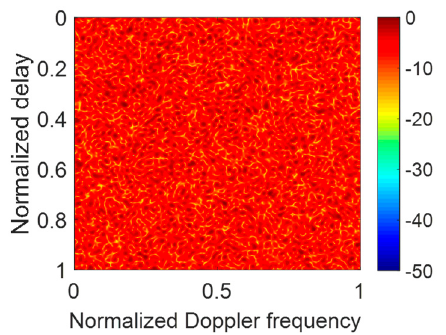
Figure 11. The result of suppressing the JRVDJ using the method of encoding the PCSs with random phase codes.